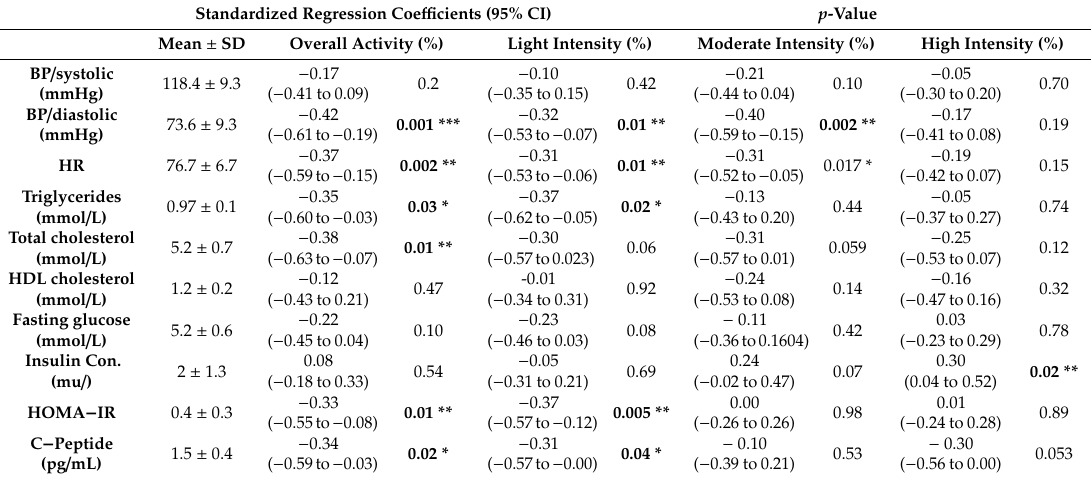
Table 2. Regression analysis of the percentage of time spent at di ff erent intensity levels of PA and metabolic risk